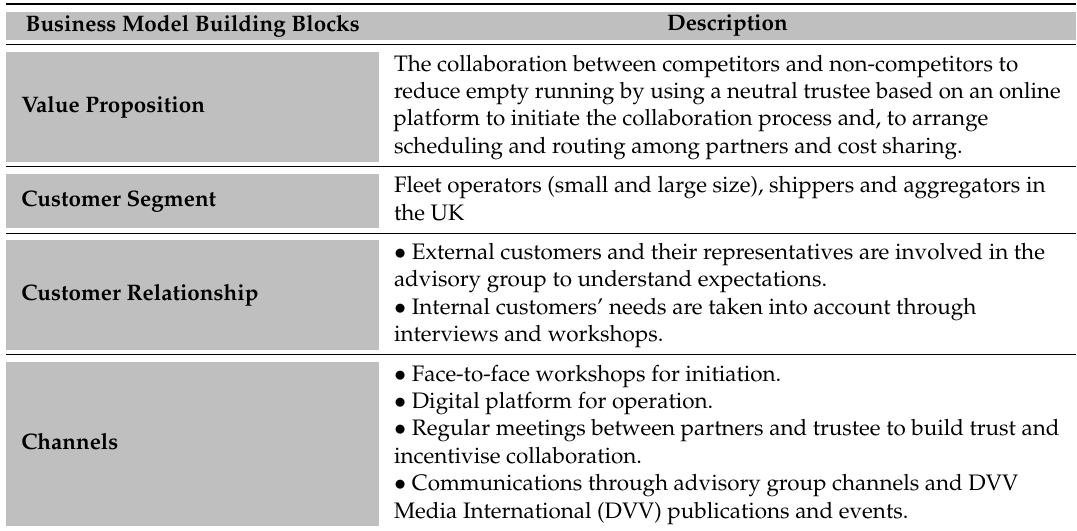
Table 5. FCBM building blocks instantiation for